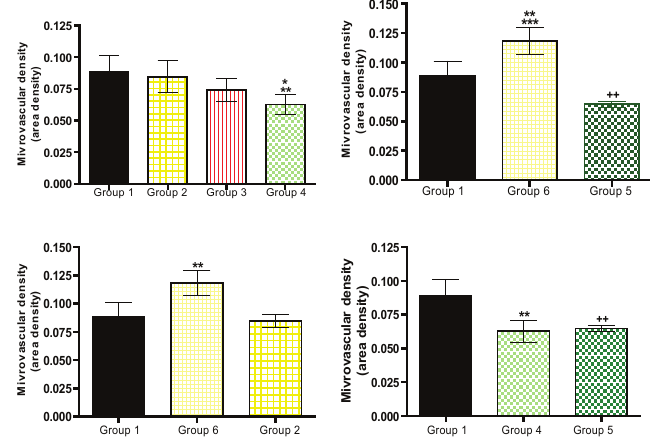
FIGURE 7 – A. Comparison of Groups 1, 2, 3 and 4 with regard to microvascular density (ANOVA and Tukey’s test). The microvascular density in Group 4 was significantly smaller than that of Group 1 (**p<0.01) and Group 2 (*p<0.05). B. Comparison of Groups 1, 6 and 5 with regard to microvascular density. The density in Group 6 was significantly greater than that of Group 1 (**p<0.01) and Group 5 (***p<0.001). The density in Group 5 was significantly smaller than that of Group 1 (++p<0.01). C. Comparison of Groups 1, 6 and 2 with regard to microvascular density. The density observed for Group 6 was significantly greater (**p<0.01) than that of Groups 1 and 2. D. Comparison of Groups 1, 4 and 5 with regard to microvascular density. The density observed for Group 1 was significantly greater than that of Group 4 (**p<0.01) and Group 5